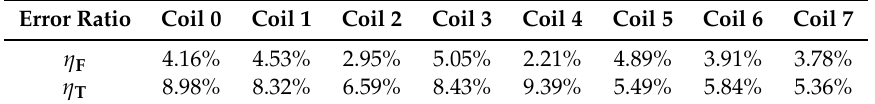
Table 3. Relative error of force and torque solutions for each coil using BEM results as a benchmark.